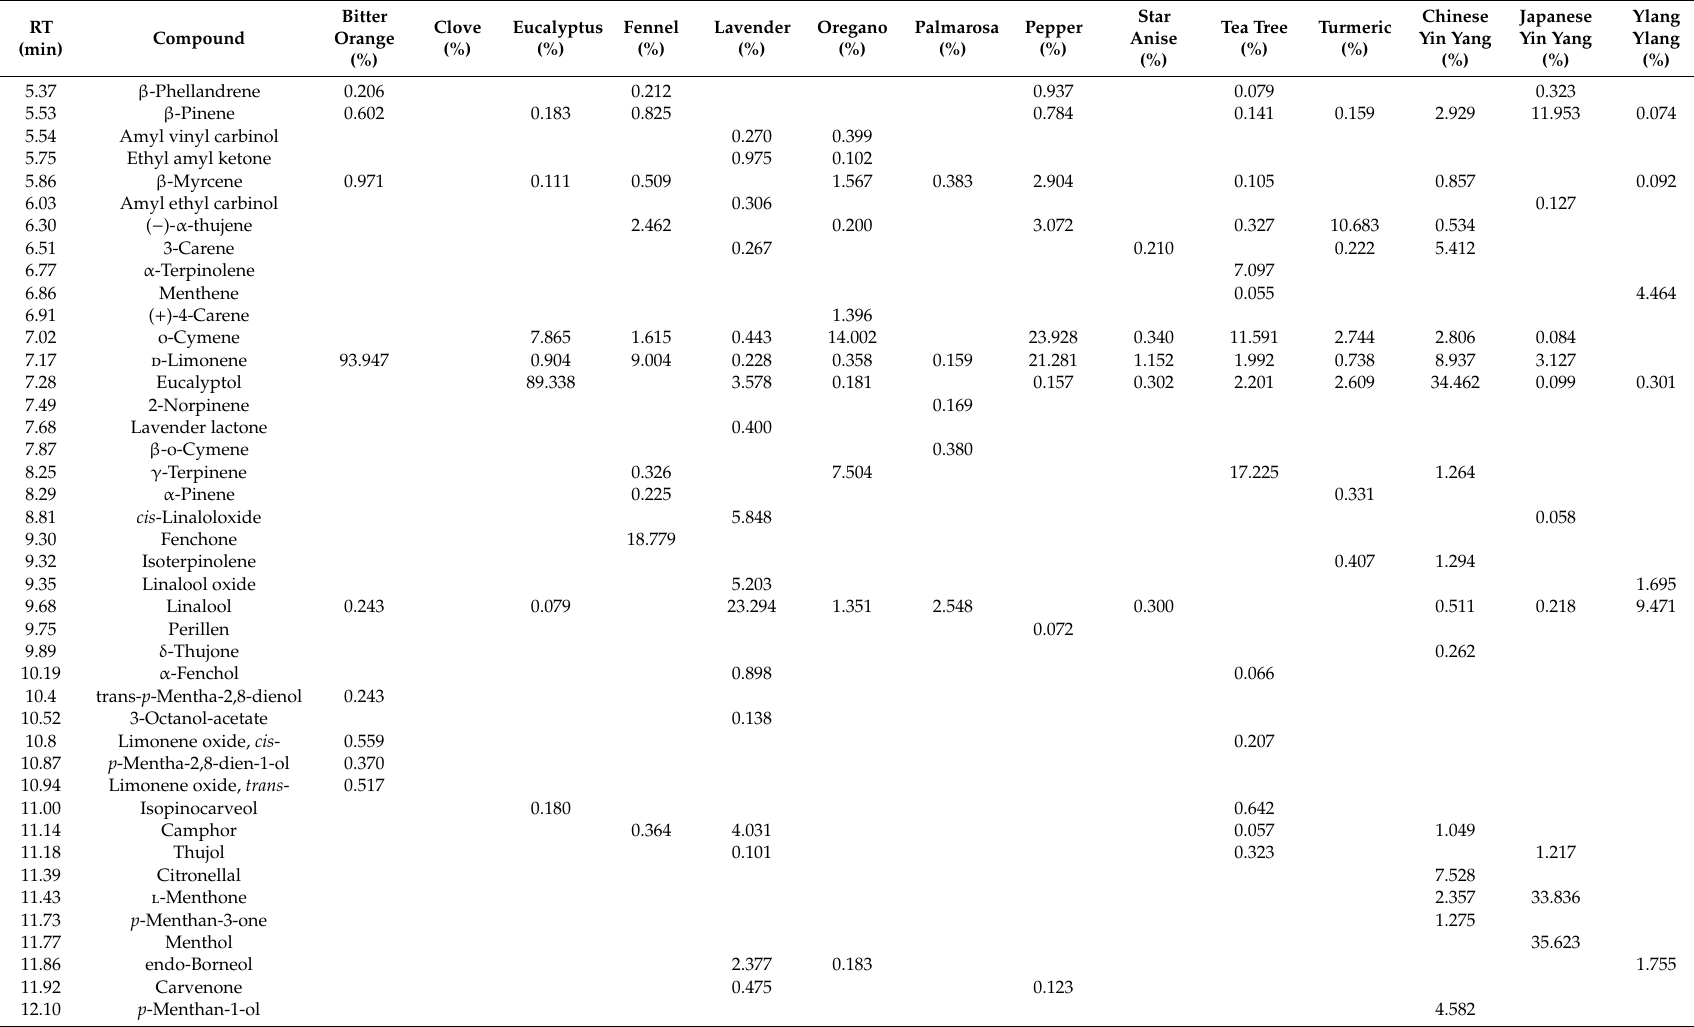
Table 1. Chemical composition of 14 essential oils (Eos) expressed as relative concentrations (% = peak area percent; RT = Retention